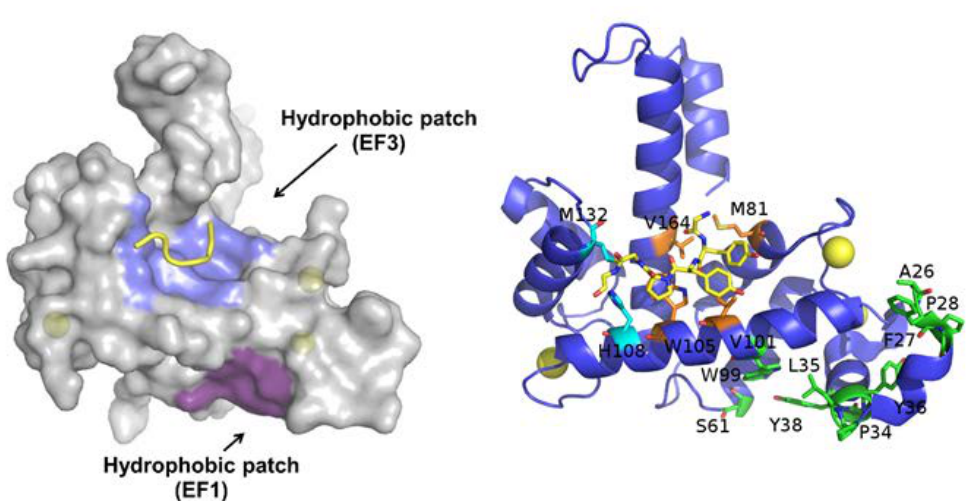
Figure 3. Ca 2 + -bound sorcin in complex with a peptide belonging to the N-terminal domain. Left: Upon calcium binding to sorcin, two hydrophobic patches are exposed to the solvent and likely mediate target binding. One patch (violet) arises from the opening of EF1, the other (blue) from EF3. The peptide belonging to the sorcin N-terminal domain is shown in yellow. Right: detail of the residues involved in the exposure of the hydrophobic surfaces upon calcium binding to sorcin, belonging to the A-helix and EF1 hand (green), and to the C-helix, D-helix, EF4 loop, and G-helix (orange and cyan). The peptide belonging to the sorcin N-terminal domain (in yellow) and the residues interacting with it are represented as sticks.